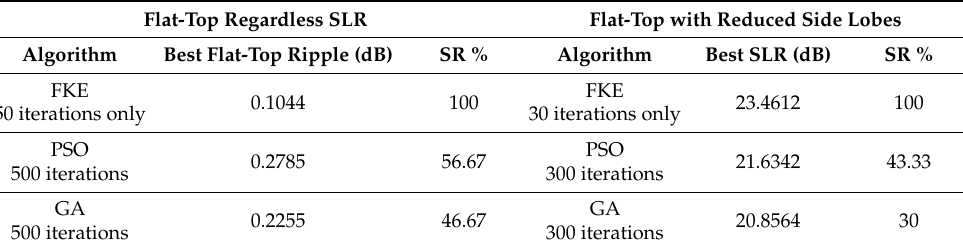
Table 5. The success rate (SR) of the proposed FKE algorithm, PSO, and GA for the flat-top pattern. (No. of runs = 30).